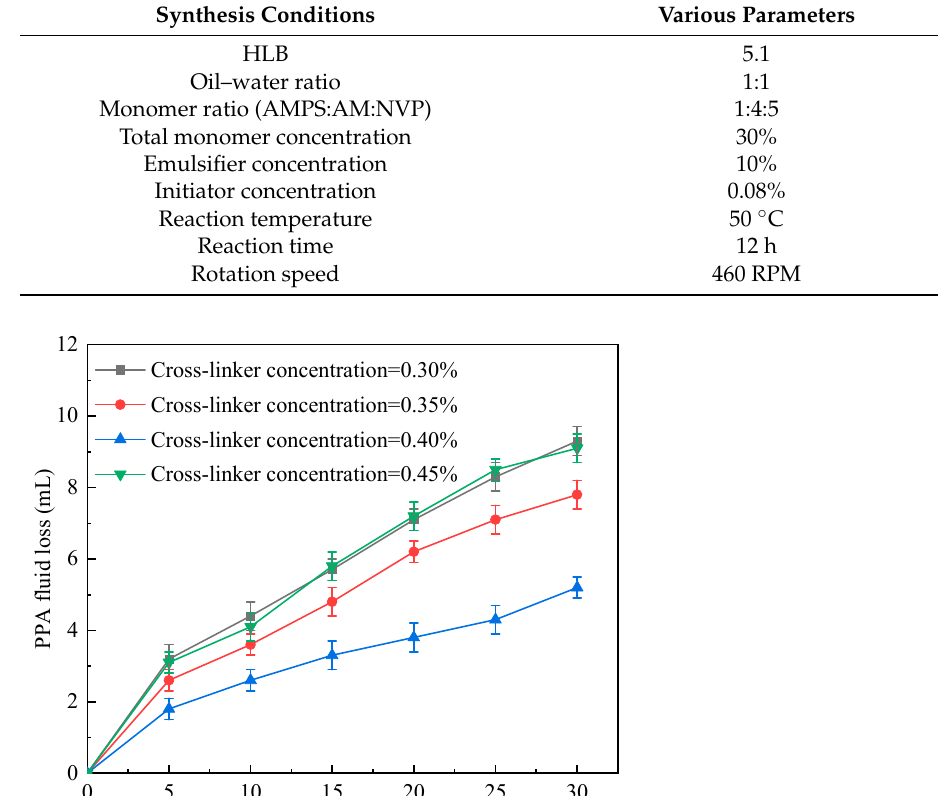
Table 5. The synthesis conditions of AMN other than cross-linker concentration.